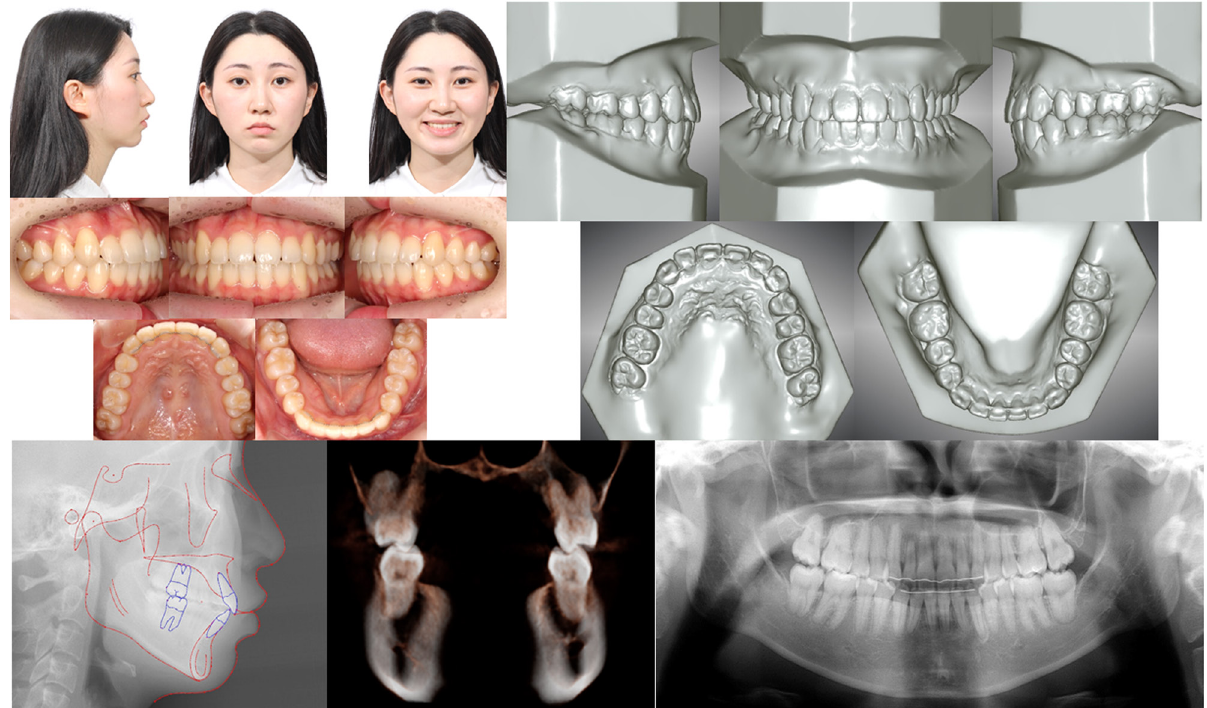
Figure 4. Post-treatment photographs, dental casts and radiographs.